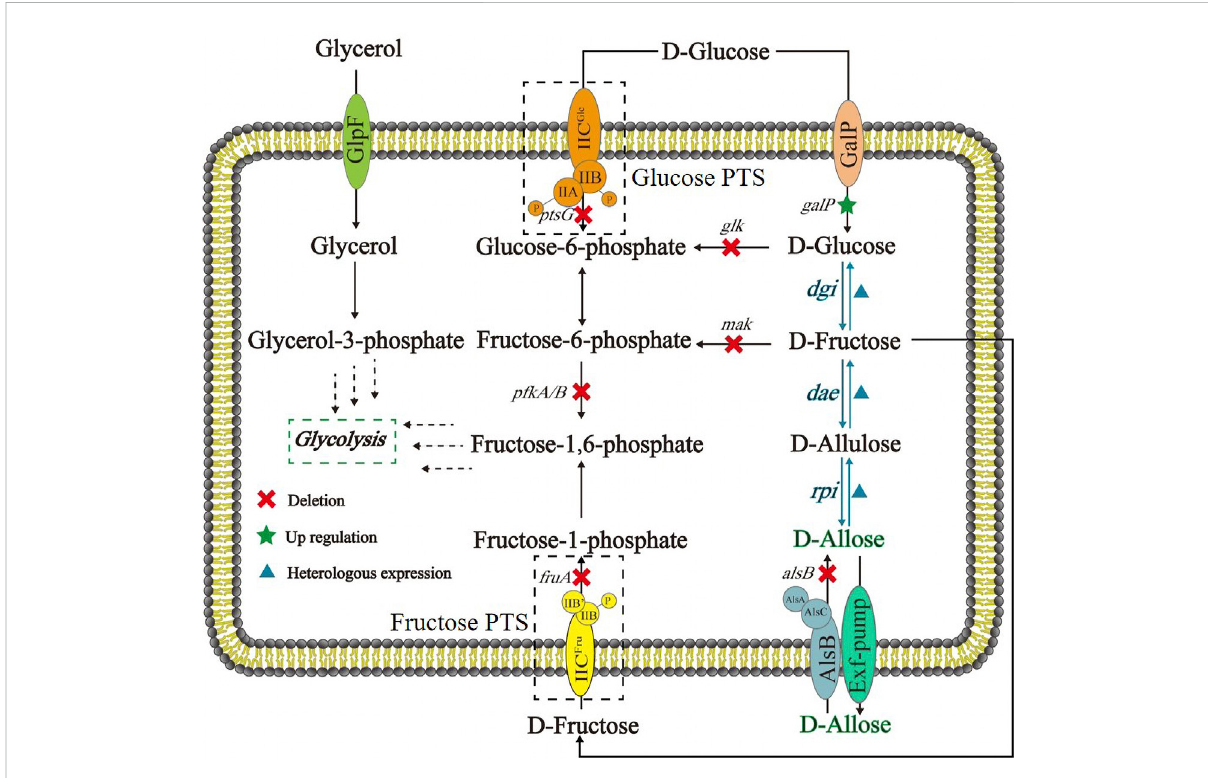
FIGURE 1 Schematic of E. coli cell factory for synthesizing D-allose from D-glucose based on Izumoring cascade epimerization. DGI: D-glucose isomerase; DAE: D-allulose 3-epimerase; RPI: ribose-5-phosphate isomerase; GalP: D-galactose H + symporter; Glucose PTS: the phosphoenolpyruvate transferase system of D-glucose; Fructose PTS: the phosphoenolpyruvate transferase system of